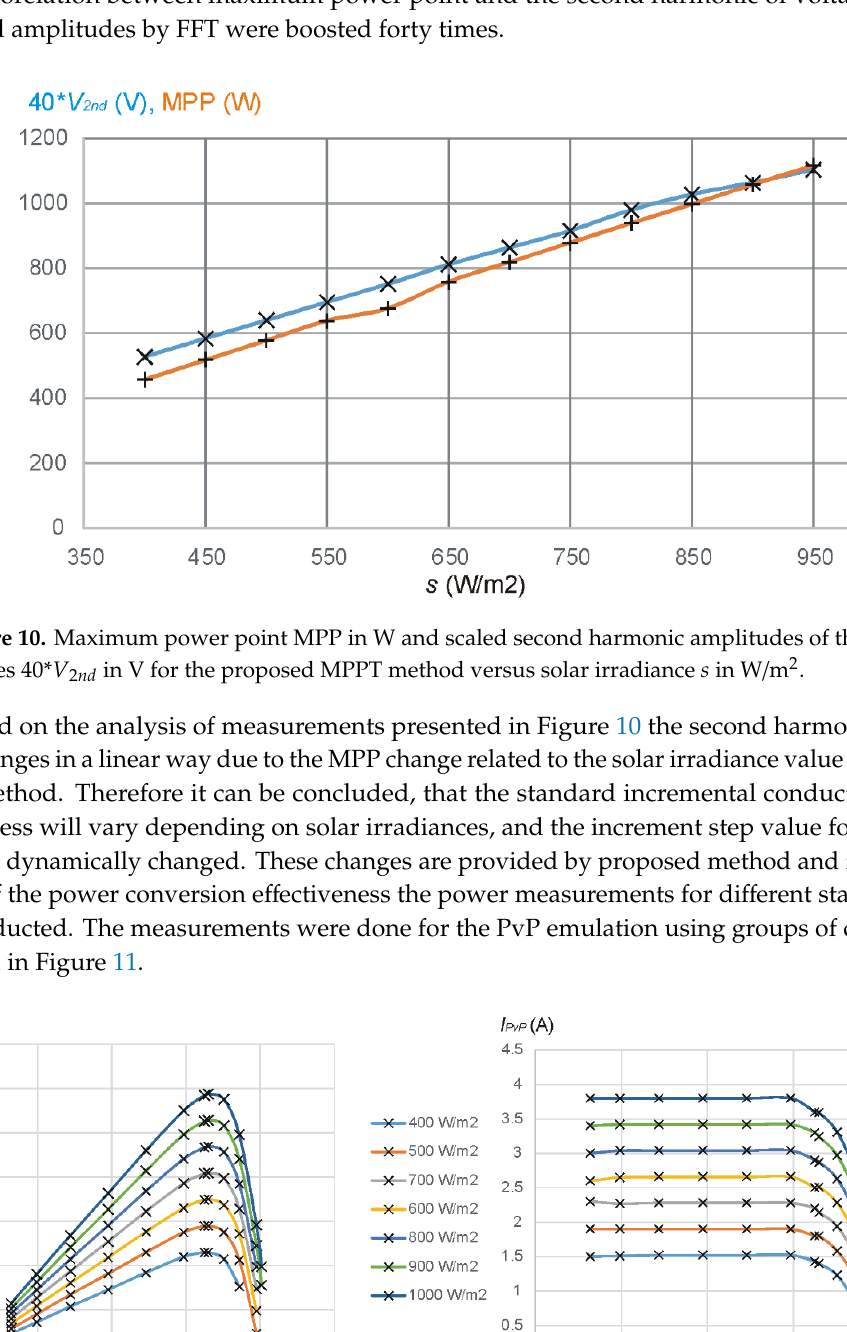
Figure 9. Measured power P in W delivered to the grid and solar irradiance s in W/m 2 for the proposed MPPT method (INC1) and for the incremental conductance MPPT method (INC2) with the incremental value tuned for solar irradiance of 900 W/m 2 .